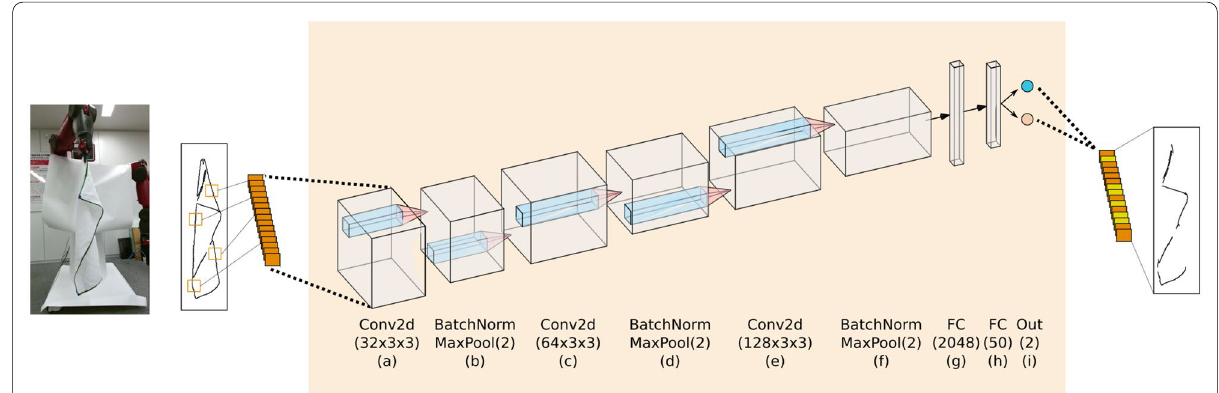
Fig. 9 The Local Detector consists of a convolutional layer a of size (32 ReLU activation. The same structure is repeated through c – d and e – f with convolutions of sizes (64 the output of (f) is rearranged as a vector of size 2048 in g ) and followed by two fully connected layers of sizes 500 and